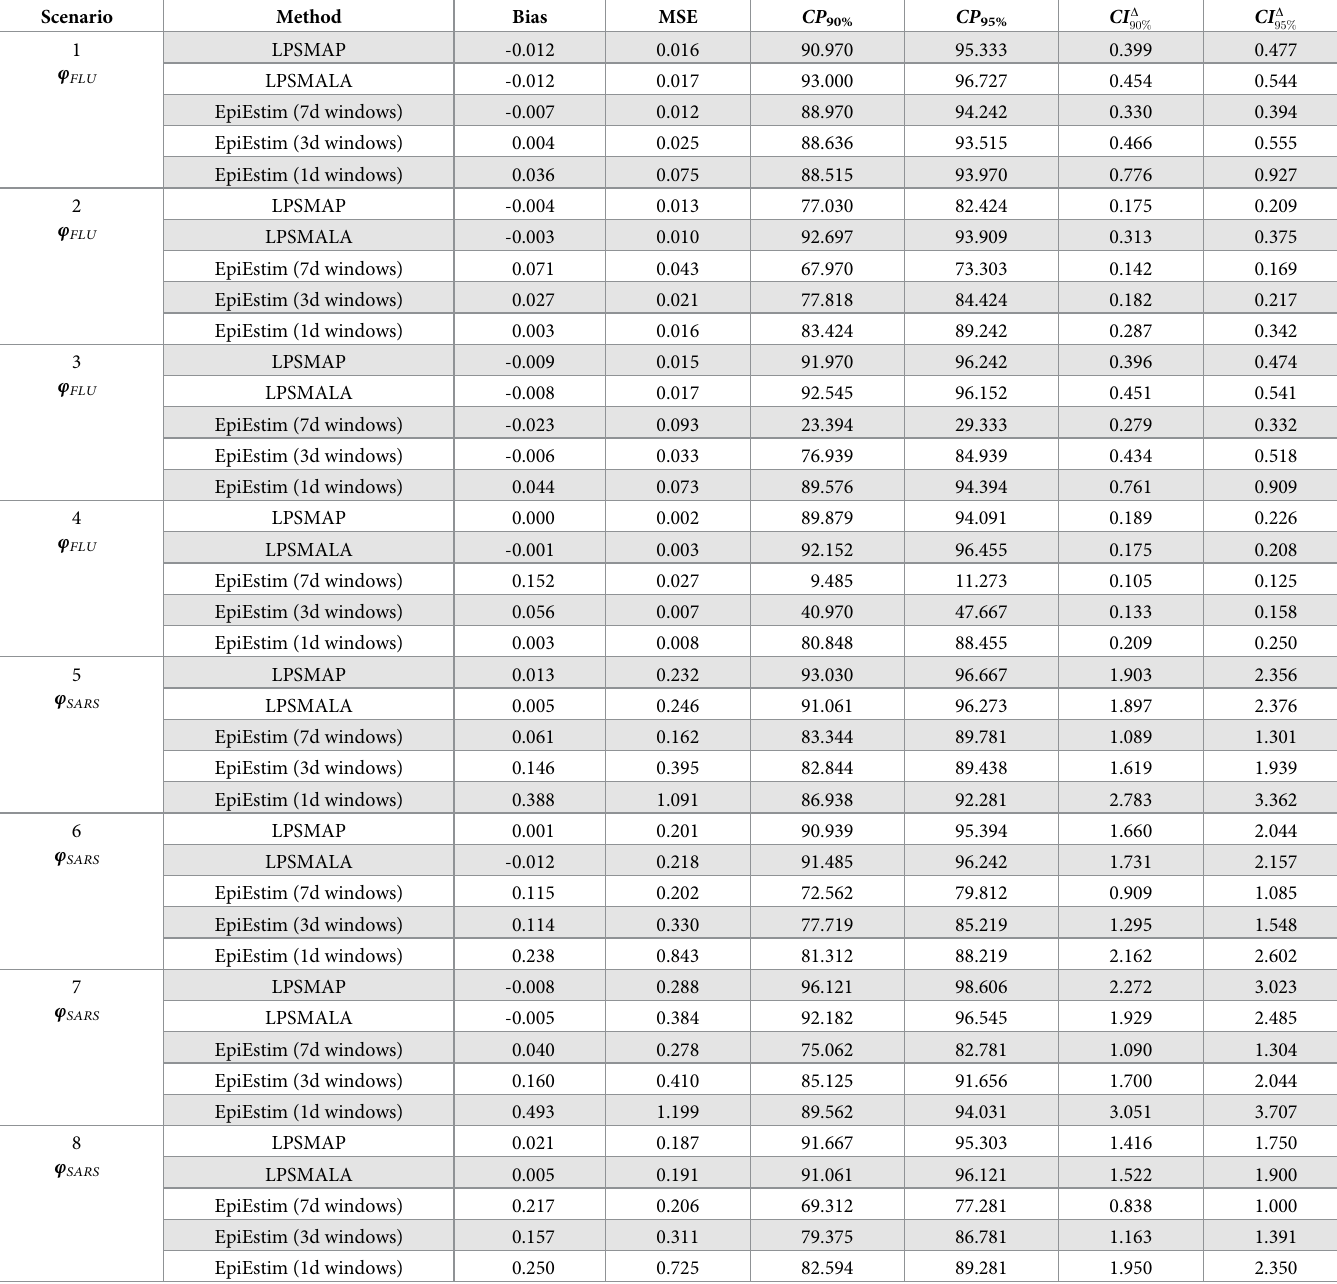
Table 2. Results for EpiLPS and EpiEstim in Scenarios 1–8 for S = 100 simulated epidemics. The Bias, MSE, coverage probability ( CP ) and width ( CI Δ ) of 90% and 95% credible intervals for R are averaged over days t = 8, ... , 40. For EpiEstim, R t